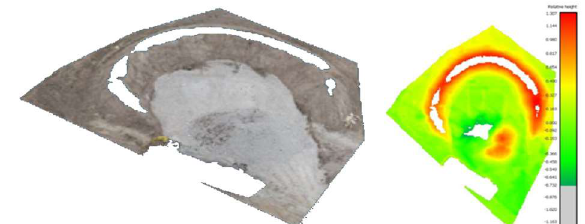
Figure 12: The gaps in point clouds because of the classification (left), the influence of these gaps on volume calculation (right).